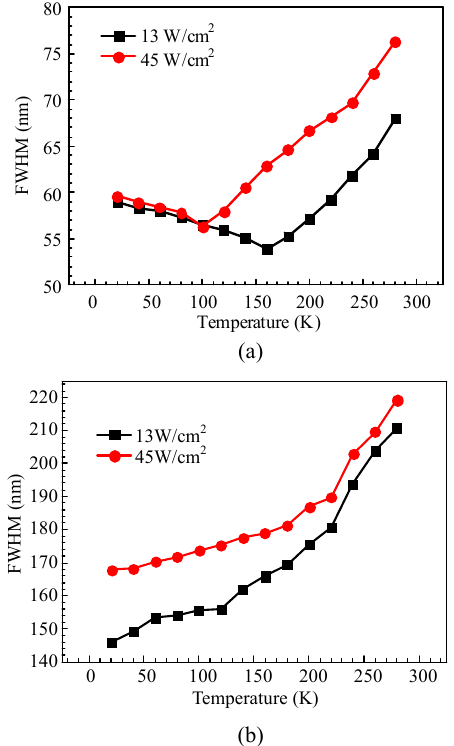
Fig. 3 FWHM of the PL peaks from (a) BQDs and (b) SQDs as functions of